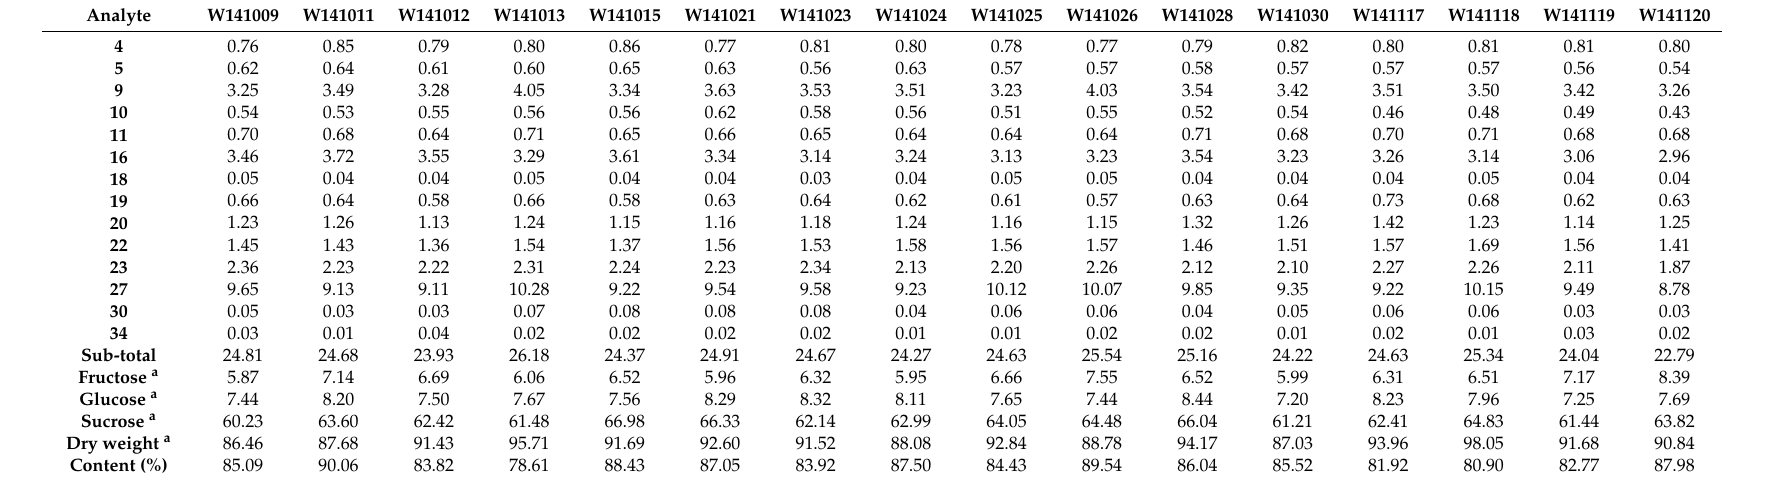
Table 3. The contents of 17 analytes in 16 batches of WLJHT by HPLC-MS/MS and HPLC-ELSD ( µ